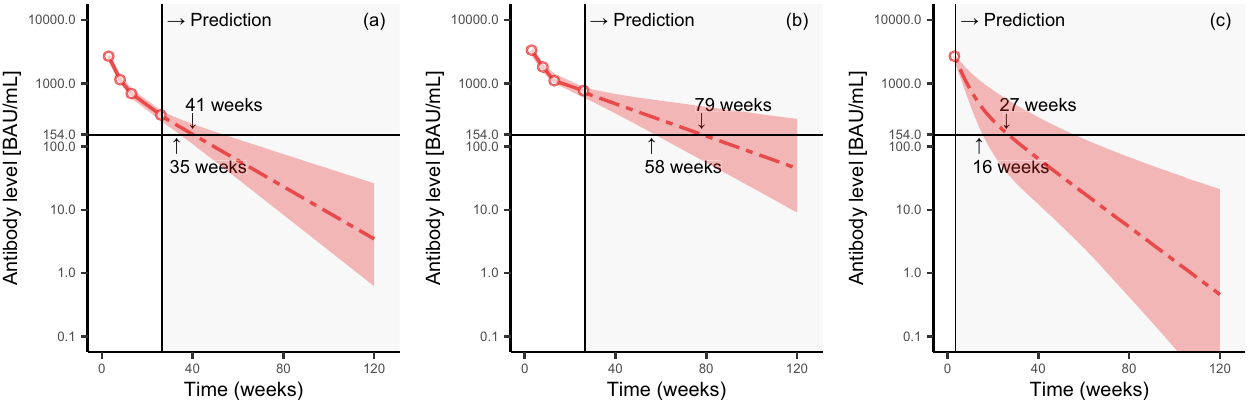
Fig. 2 Prediction results. Prediction results from fi tting the best- fi t model to three selected participants from Keio University Hospital. The area to the right of the vertical reference line displays the predicted results. Data and predicted results of antibody titers (anti-receptor- binding domain IgG) for a participant whose antibody titer increased to approximately 2500 BAU/mL ( a ) and 3500 BAU/mL ( b ) after two vaccination doses. c Data and predicted results for a participant with only one measurement available (week 3) owing to missing data. Time instants are shown when the lower limit of the 95% prediction interval and the median value falls below the 154 BAU/mL threshold, the horizontal reference line, for classi fi cation as a protective antibody titer. The vertical axis represents the logarithmic scale.